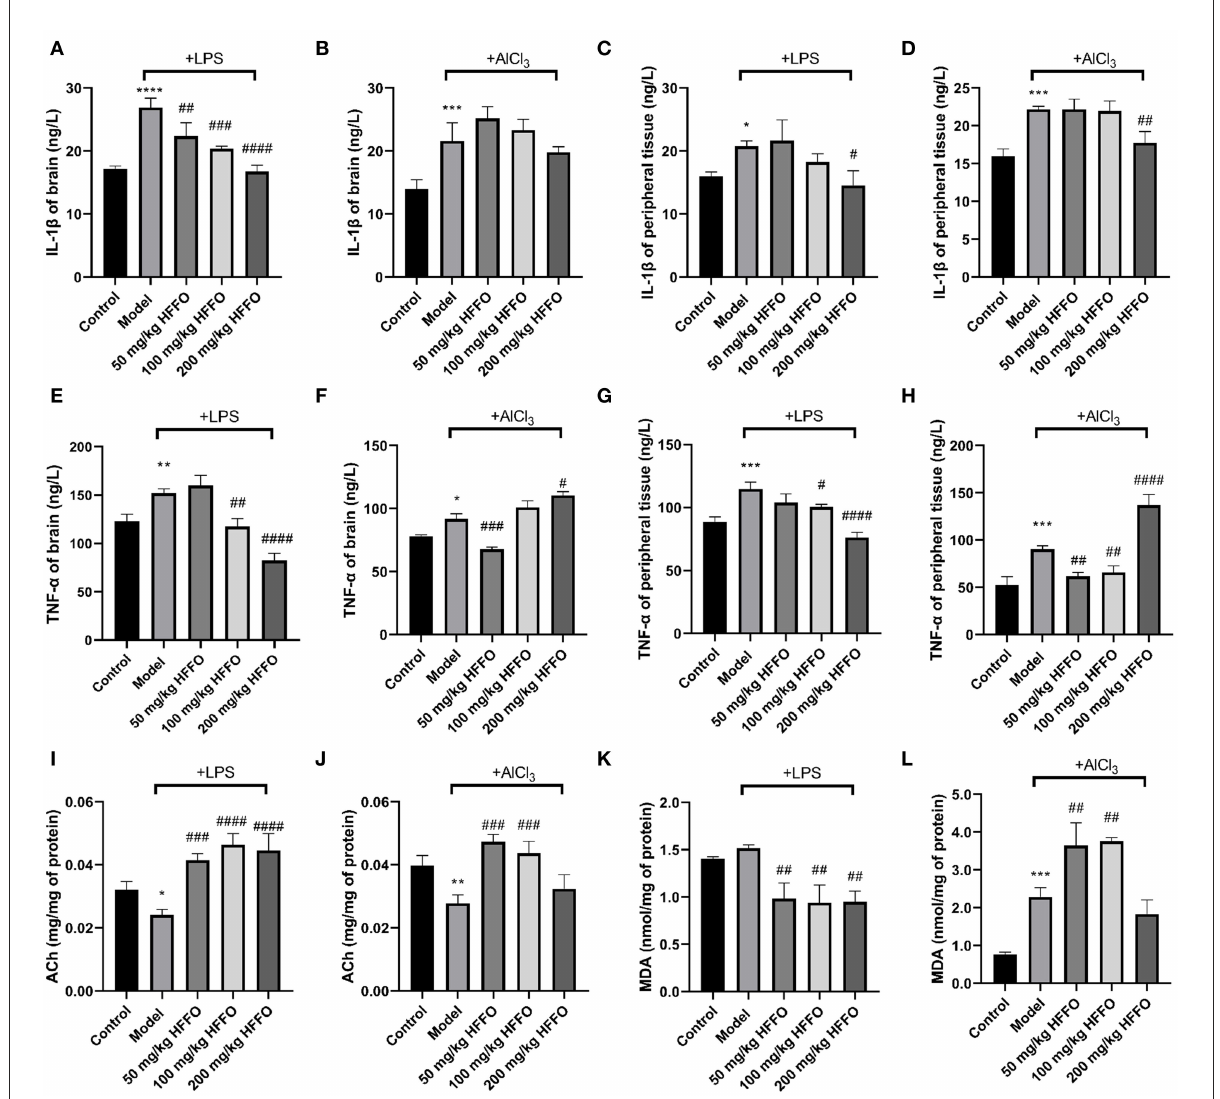
FIGURE3 IL-1 β (A–D) and TNF- α (E–H) content in zebrafish brain and peripheral tissue, and ACh (I,J) and MDA (K,L) levels in zebrafish brain tissue. n = 3, * p < 0.05, ** p < 0.01, *** p < 0.005, **** p < 0.001, vs. the control group; # p < 0.05, ## p < 0.01, ### p < 0.005, #### p < 0.001, vs. the model group.